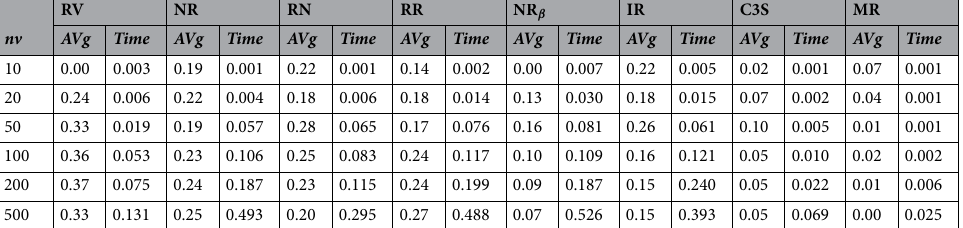
Table 9. AVg and Time variations according to nv for all algorithms.